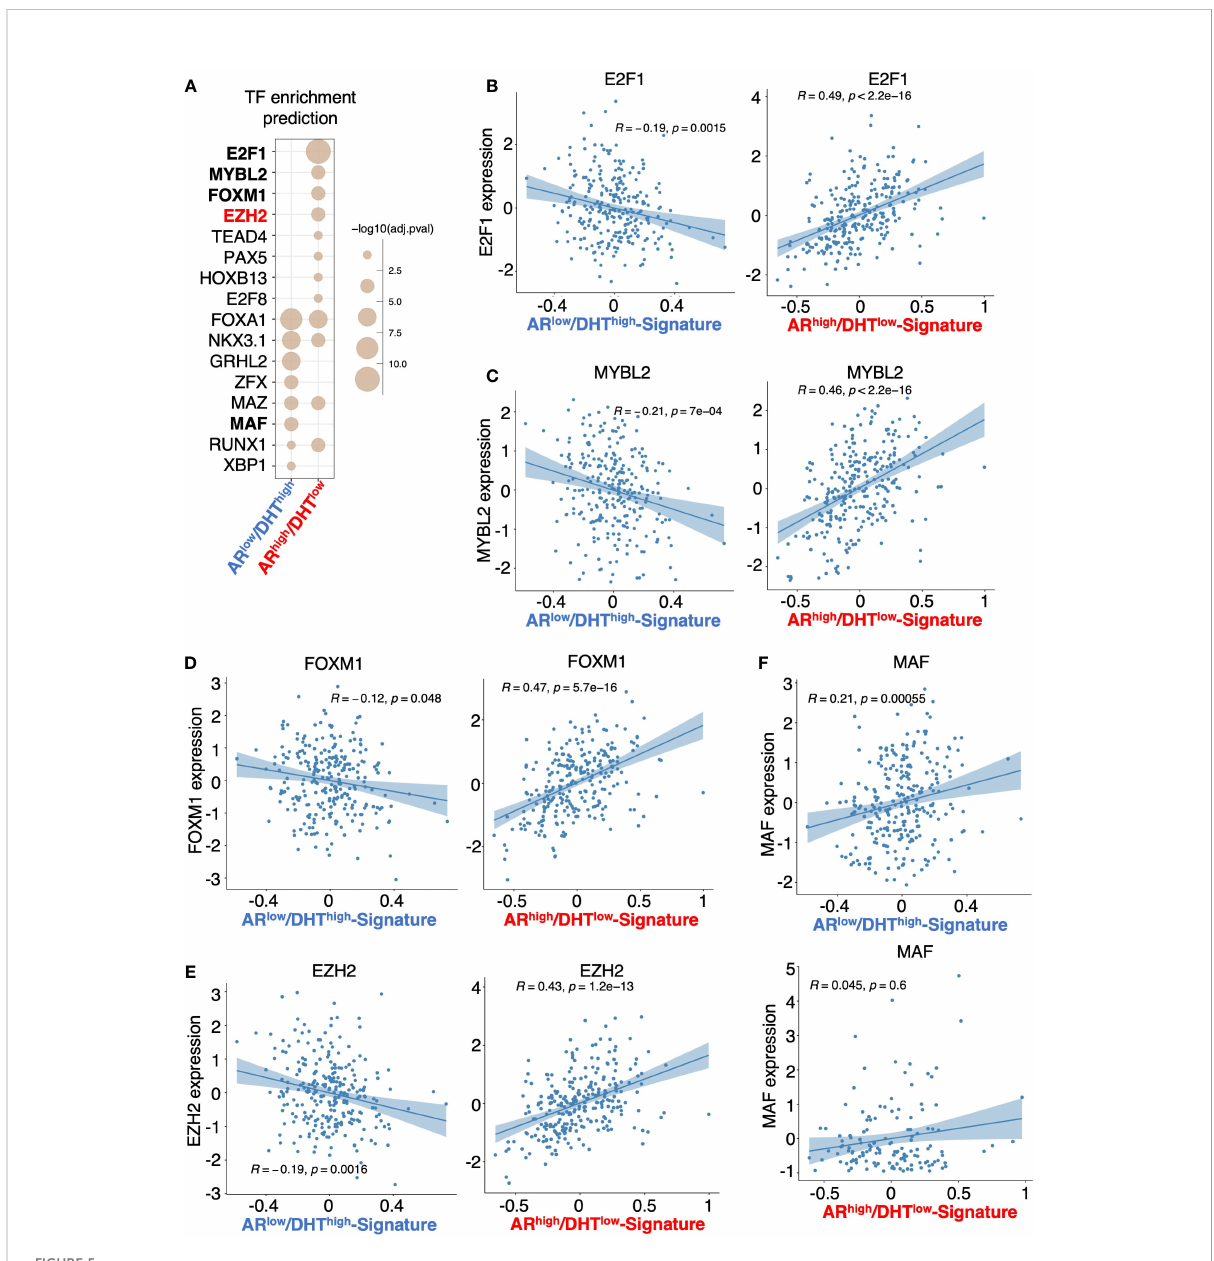
FIGURE 5 Prediction of transcription or epigenetic factors involved in the reprogramming of AR. (A) Prediction of the involvement of transcription factor/ chromatin regulator in mediating AR activity in AR low /DHT high cells or AR high /DHT low cells using Causal Inference Enrichment (CIE) platform for signi fi cant gene expression (fold-change > 2, FDR < 0.05). ChIP-Atlas prostate cell line dataset was selected as the database, and Fisher ’ s exact test was used as the enrichment method. Enriched factors with adjusted P -value < 0.05 are shown. (B – F) Correlation of predicted factors, E2F1 (B) , MYBL2 (C) , FOXM1 (D) , EZH2 (E) , and MAF (F) , with the expression of AR low /DHT high signature or AR high /DHT low signature in mCRPC patient